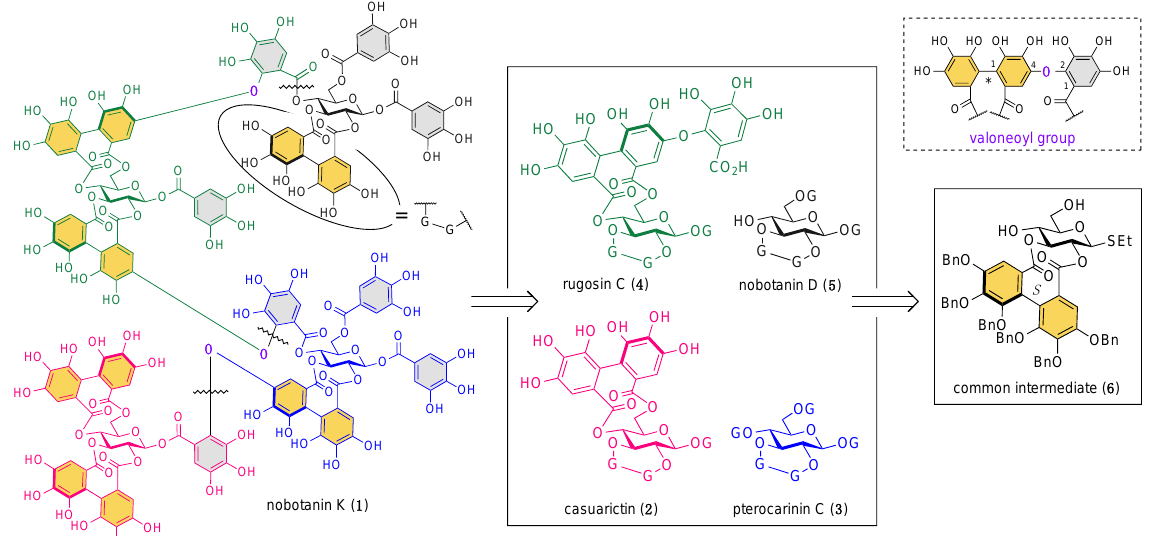
Figure 2. Structure of the tetrameric ellagitannin, nobotanin K ( 1 ), and this compound’s retrosynthetic strategy. G – G: ( S )-HHDP.